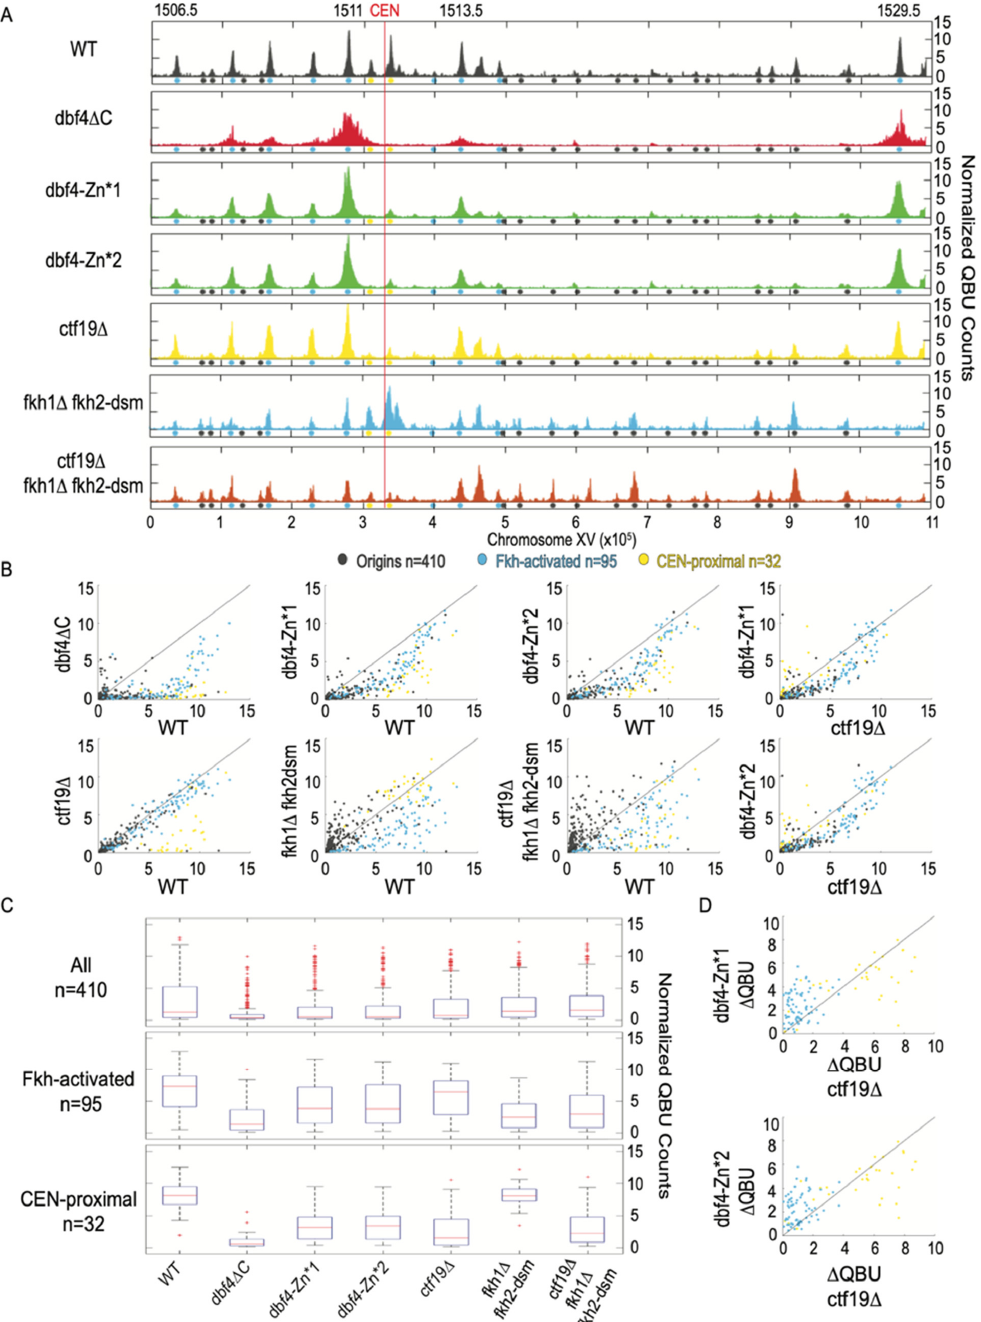
Figure 3. Dbf4-Zn* is defective in CEN-proximal origin firing. Strains described in Figures 1 and 2 legends were synchronized in G1 phase, released into S phase with HU for 60 min (90 min for dbf4 ∆ C), and harvested for QBU analysis. ( A ) QBU values averaged for two replicates and scale-normalized across strains are shown for representative chromosome XV; origins and origin sub-groups are indicated with color-coded circles below the x-axis. ( B ) Two-dimensional scatter plots comparing QBU signals averaged across 500 bp regions centered on 410 confirmed origins; origins and sub-groups are color-coded as indicated. ( C ) Boxplot distributions of averaged QBU counts across 500 bp regions aligned on origins of the indicated groups; the number of origins in each group is indicated within parentheses; results of statistical analyses are given in Table S1. ( D ) Two-dimensional scatter plot comparing the differences in QBU values for ctf19 ∆ (WT-ctf19 ∆ ) versus dbf4-Zn* (WT-dbf4-Zn*) for Fkh-activated and CEN-proximal